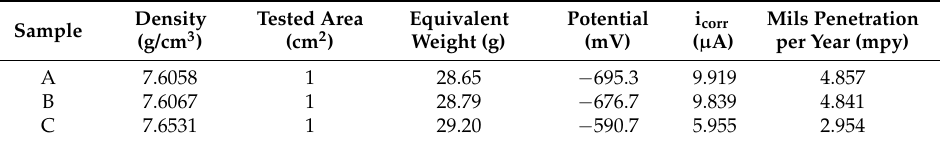
Table 3. Comparison of the effect of different chromium percentages on the corrosion rate and mils penetration per year of dual-phase high carbon